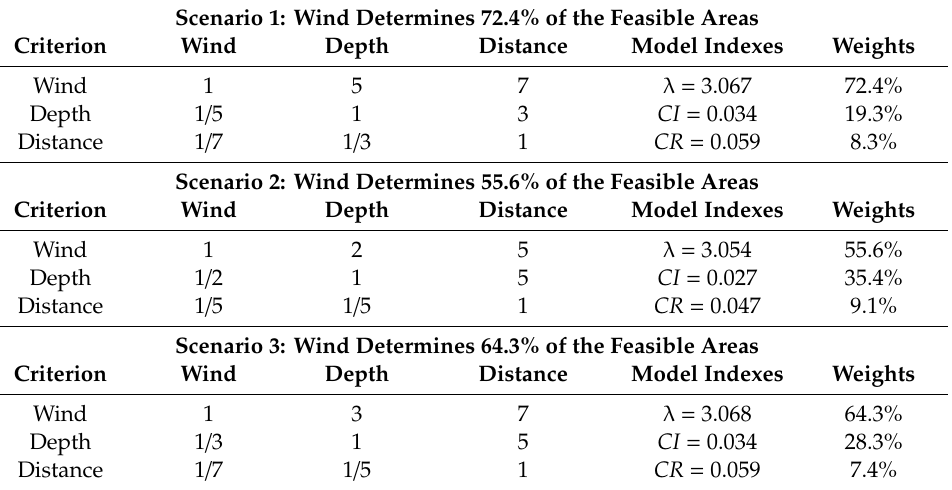
Table 5. Two-by-two matrices and the respective weights for each